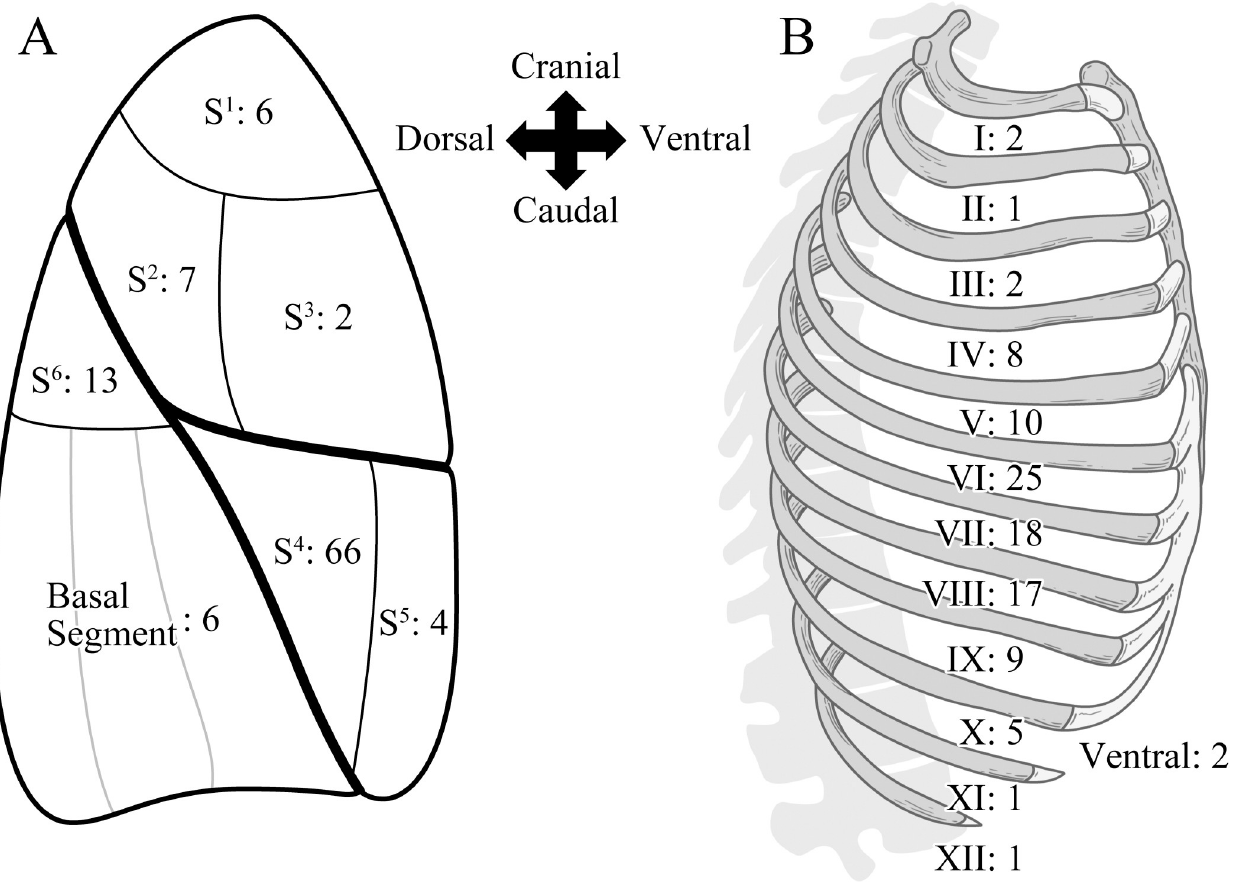
Fig 2. Distribution of endometriotic lesions. (A) Visceral pleural lesions, and (B) Parietal pleural lesions. Eighty-six visceral pleural lesions (82.7%) out of 104 were observed in S 4 , S 6 , and S 2 . Eighty-seven parietal pleural lesions (86.1%) out of 101 were observed in 4 th -9 th dorsal intercostal space.